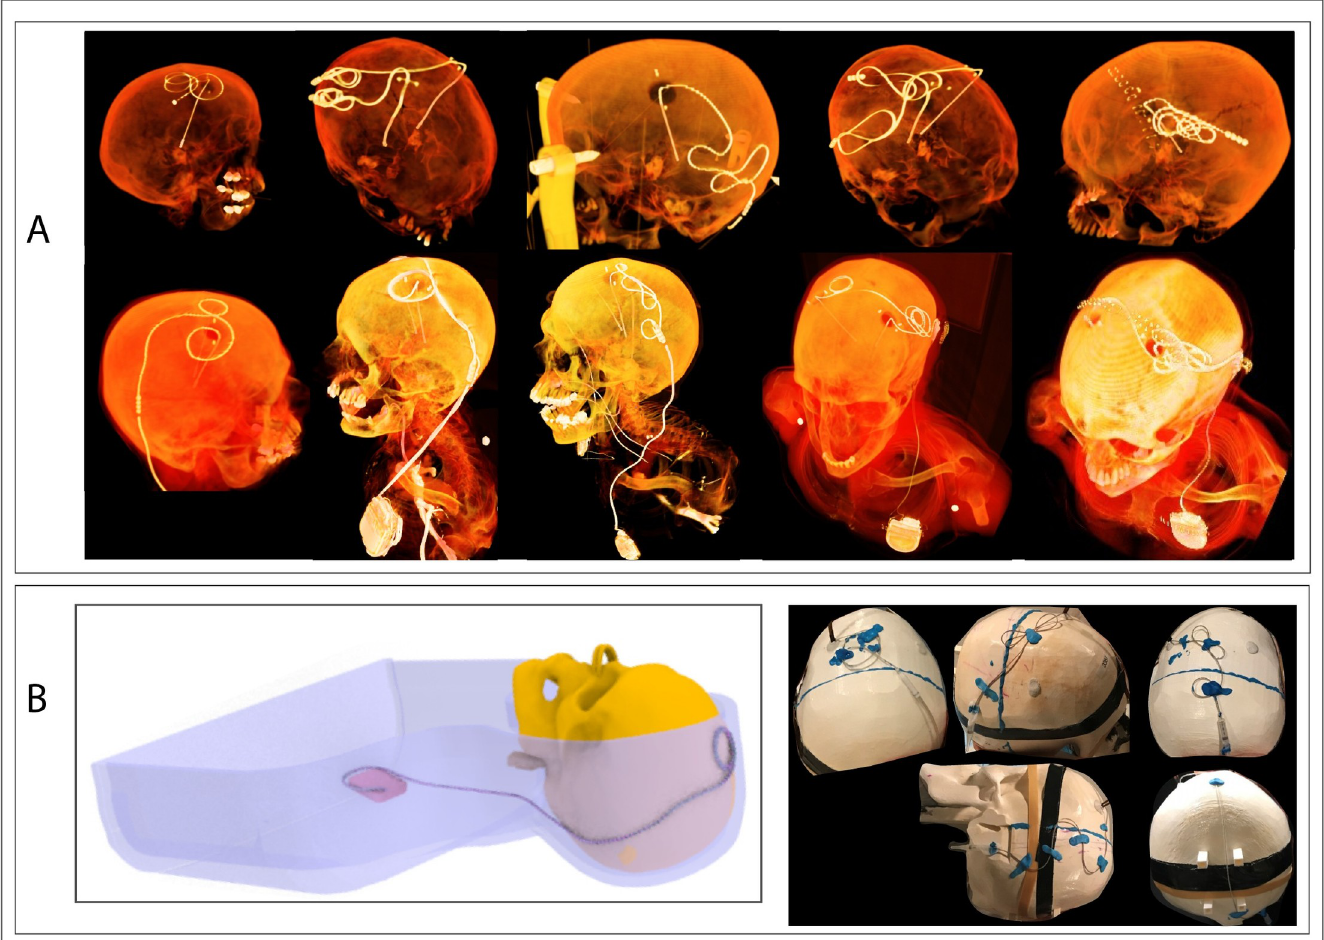
Fig 2. DBS trajectory configurations. (A) 3D-rendered postoperative CT images of DBS patients showing typical trajectories of extra-cranial leads and extensions. (B) Schematic of the phantom implanted with a full DBS device as well as examples of some trajectories used in RF heating experiments. https://doi.org/10.1371/journal.pone.0257077.g002 PLOS ONE | https://doi.org/10.1371/journal.pone.0257077 September 7,